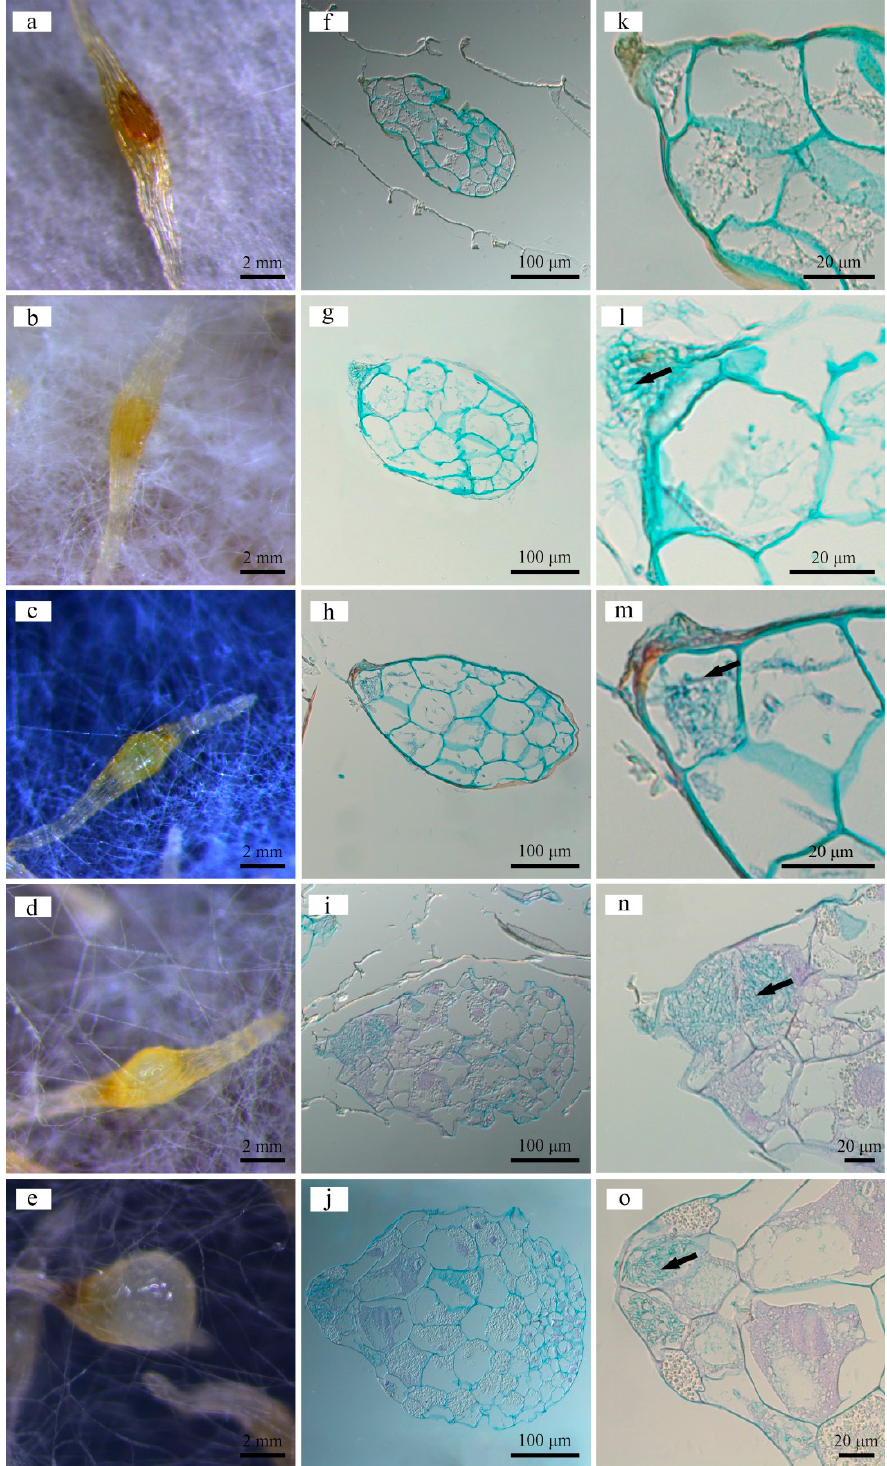
Figure 1. Macroscopic and histological observations of coculture of Gastrodia elata seeds and Mycena sp. WM captured on the initial ( a , f , k ), 5th ( b , g , l ), 10th ( c , h , m ), 15th ( d , i , n ), and 20th ( e , j , o ) days. ( a – e ) Macroscopic view under a stereoscope; ( f – j ) histological sections of G. elata seed under a microscope; ( k – o ) partial enlarged details of the picture in b showing base cells. Arrows indicate the Mycena hyphae invading the seed cell.